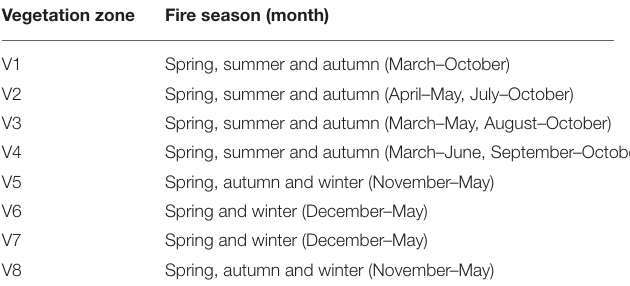
regime zoning system, including the variables of fire density, average burned area per fire, fire season duration, and SSR